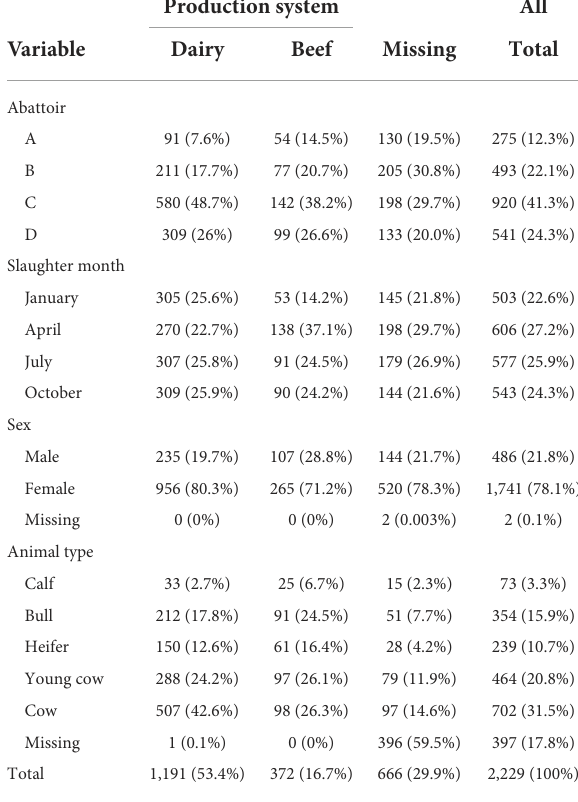
TABLE 2 Descriptive table of database, showing variables by production system, missing and